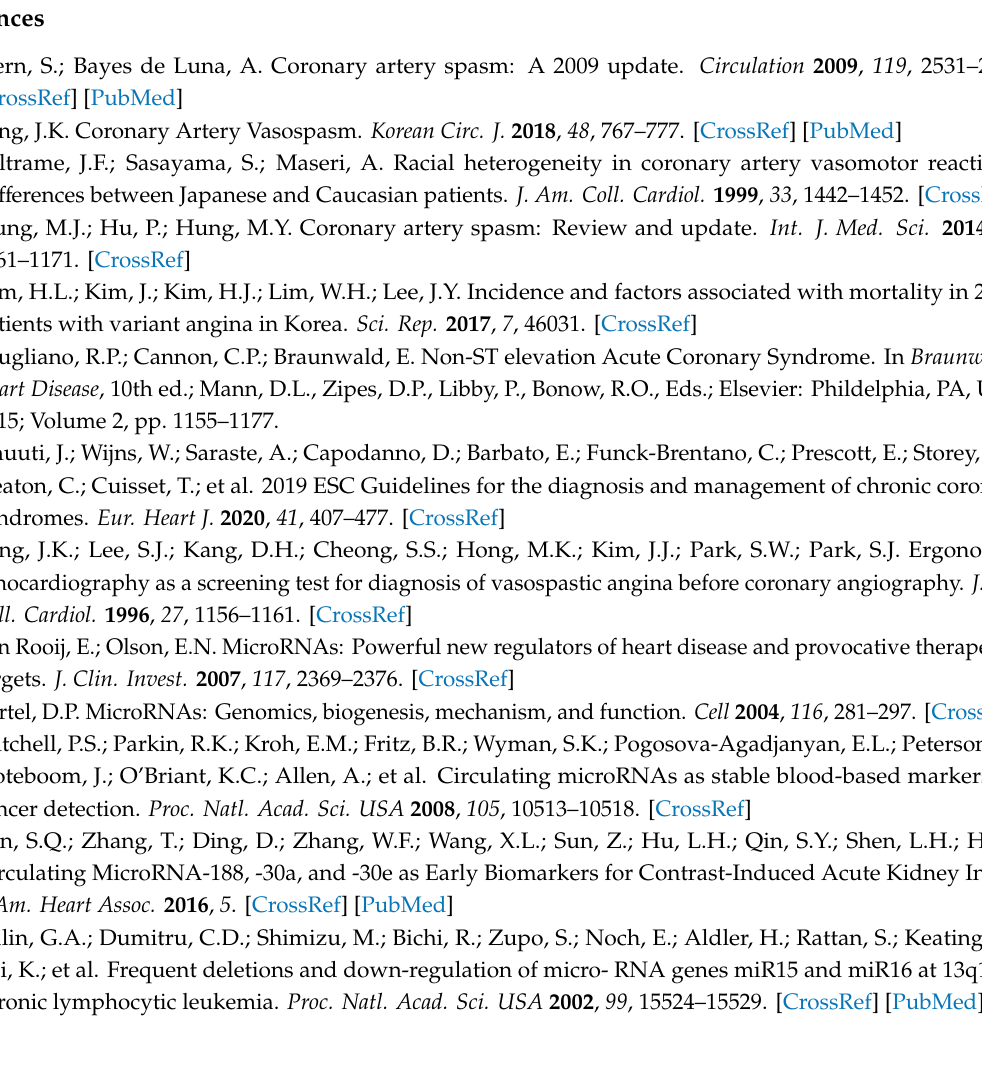
Figure S1: Distinction of patients according to miR profile between VA group and other groups, Figure S2: The role of miRs in endothelial eNOS and KLF2 protein expression, Figure S3: eNOS protein expression in hCAECs after LPS treatment, Figure S4: The role of miR modulation in eNOS protein expression in hCAECs treated with LPS, Figure S5: Target scan of KLF2 gene, Table S1: Primer sequence, Table S2: Plasma miRNA levels at baseline detected by